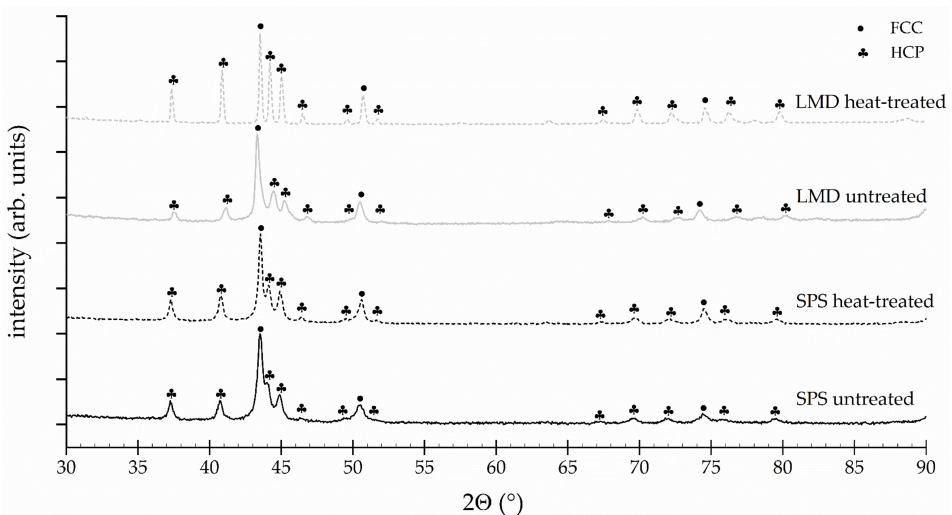
Figure 3. Diffractograms of Al 0.3 CoCrFeNiNb 0.5 untreated and heat-treated SPS bulk material and